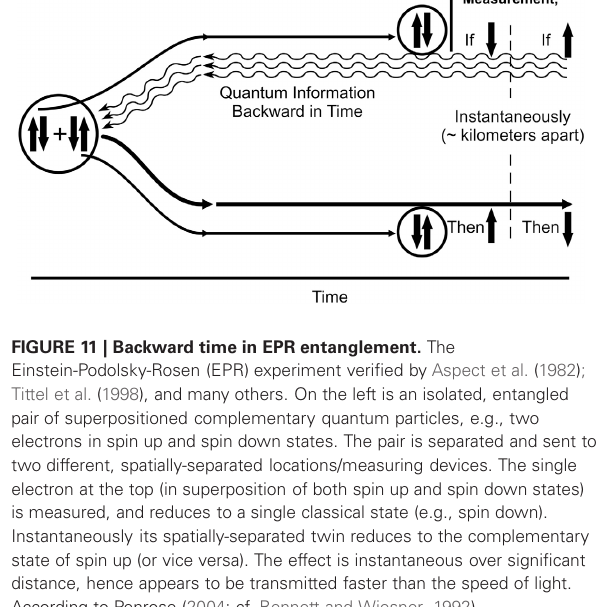
FIGURE 12 | Three toy neurons in an input/integration layer. Adjacent dendrites are connected by gap junction electrical synapses in “dendritic web,” showing internal cytoskeletal microtubules connected by microtubule-associated proteins. Insert: communication/correlation between microtubules through gap junctions by electromagnetic or quantum entanglement, enabling collective integration among gap junction-connected, synchronized neurons and